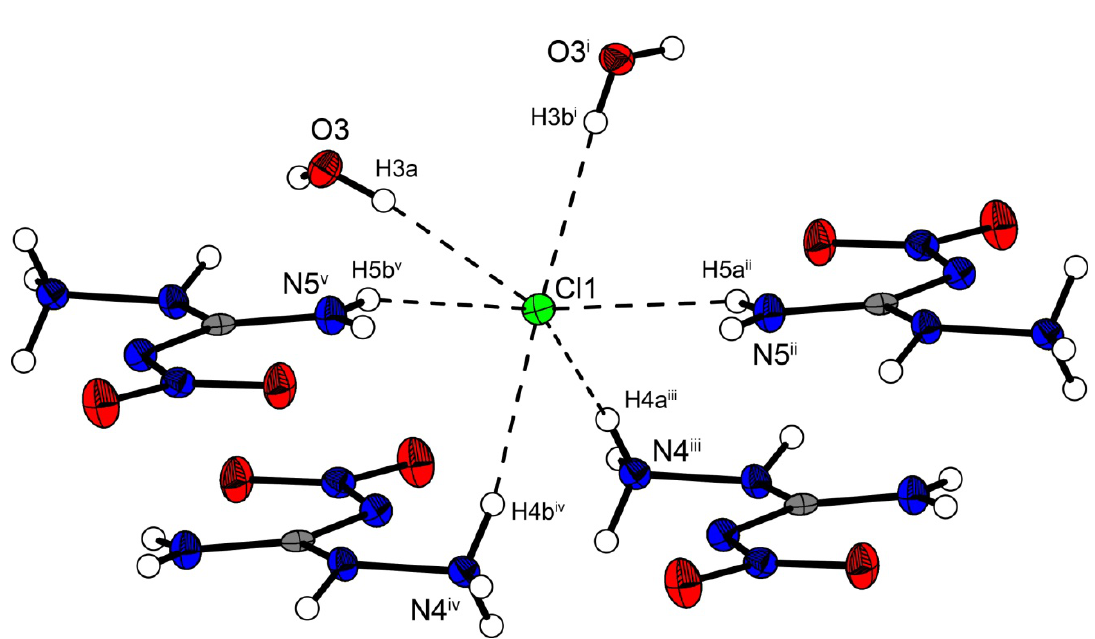
Figure 3. Coordination sphere of one chloride anion in 2 . Symmetry codes: (i) 0.5 + x , 0.5 − y , 0.5 + z ; (ii) 1.5 − x , 0.5 + y , 1.5 − z ; (iii) − 0.5 + x , 0.5 − y , 0.5 + z ; (iv) 0.5 − x ,